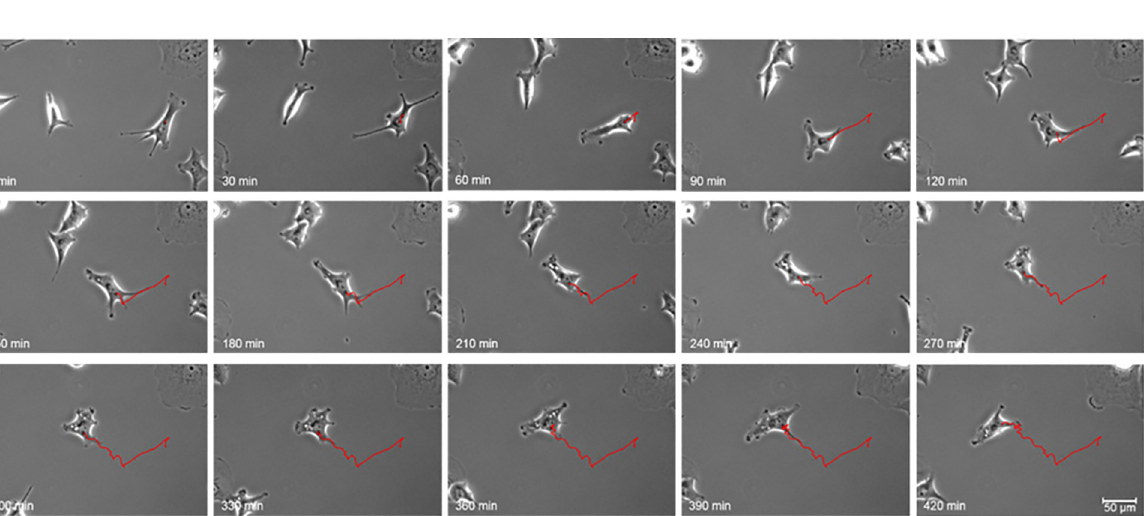
Fig 7. Illustration of cell movement. Hs746T cell movement was tracked for 7 hours. The position of one exemplary cell in 30 minute intervals is depicted. The red line indicates the trajectory of the cell.